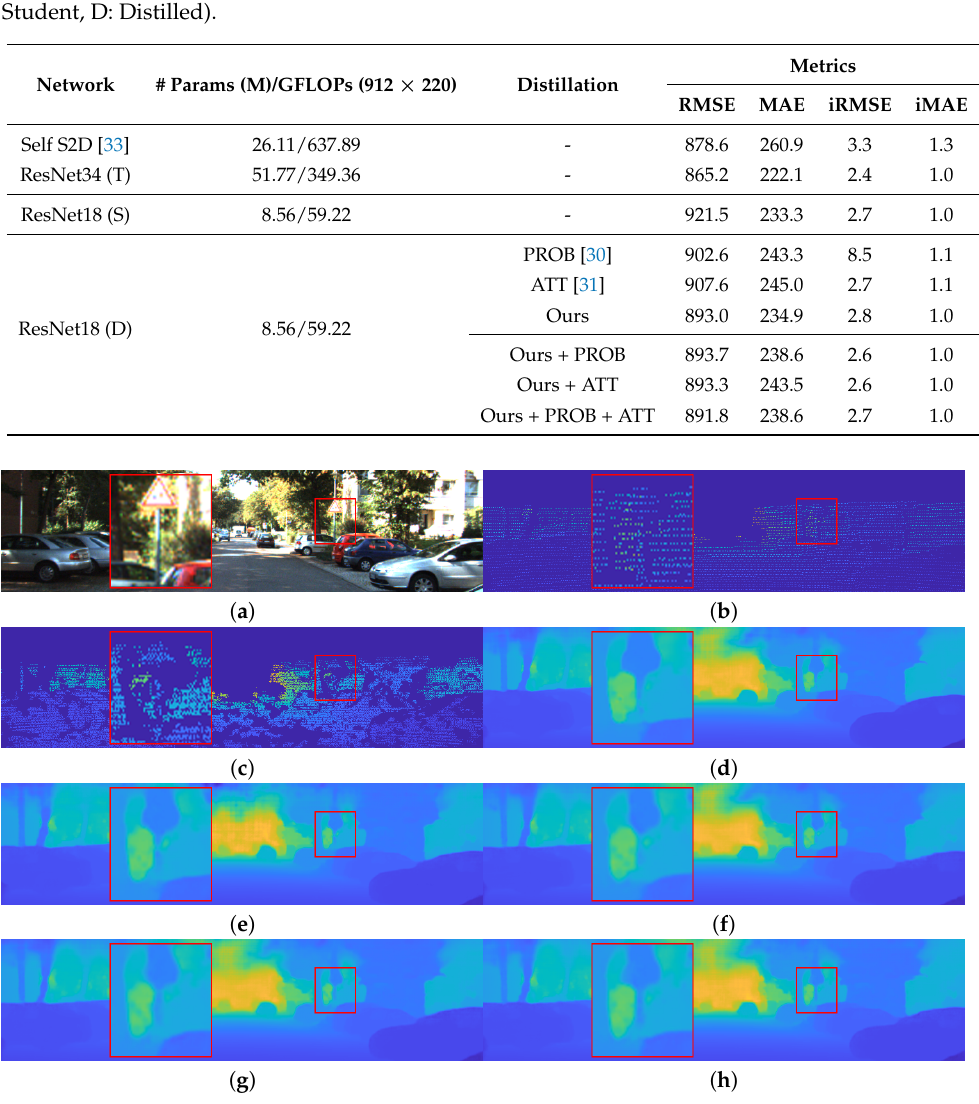
Figure 2. Depth prediction results on the KITTI DC validation dataset [32]. ( a ) RGB. ( b ) Sparse Depth. ( c ) GT. ( d ) Teacher. ( e ) Student. ( f ) PROB [30]. ( g ) ATT [31]. ( h )